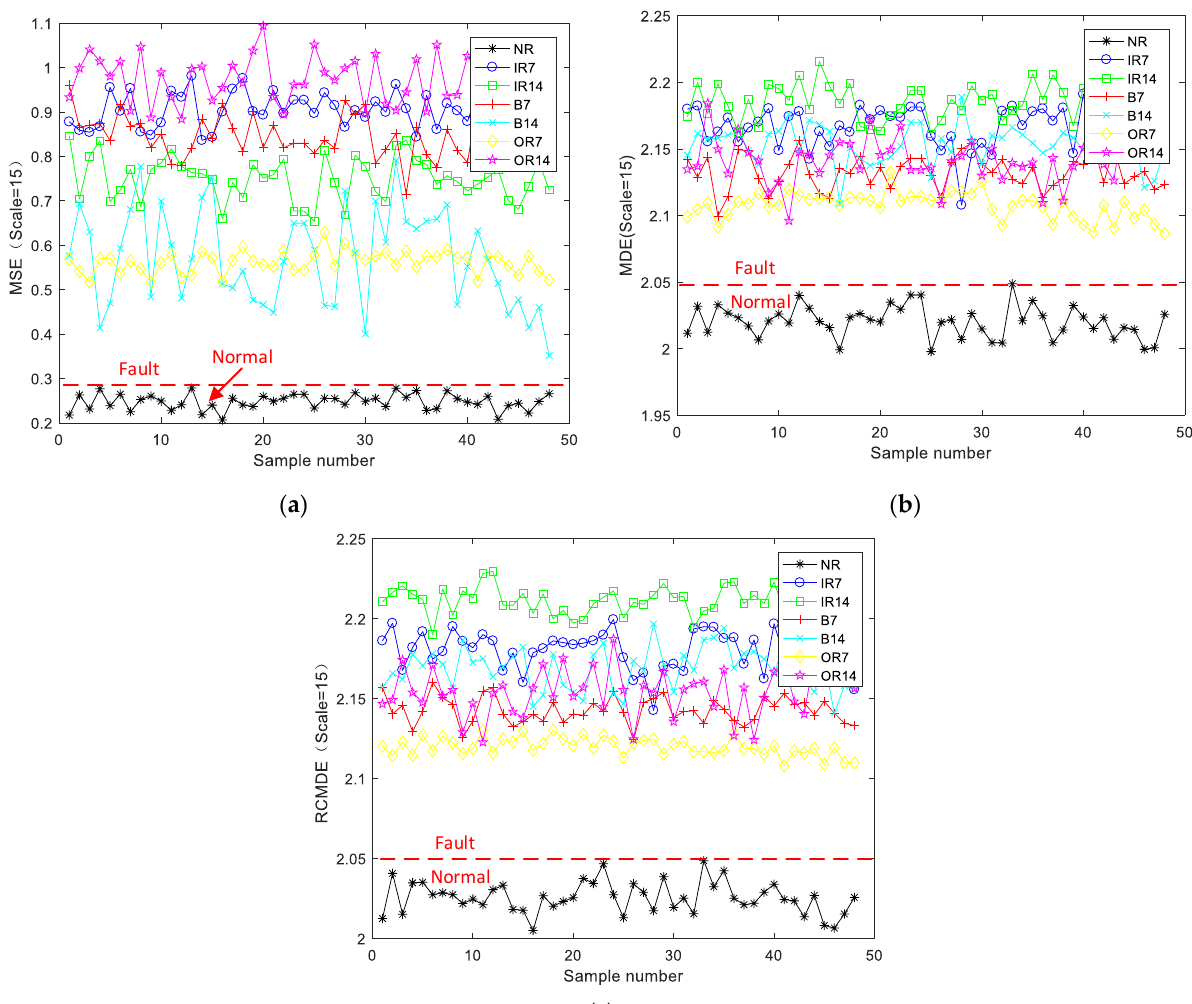
Figure 5. Entropy distribution of all samples (scale = 15): ( a ) MSE; ( b ) MDE; ( c ) RCMDE.